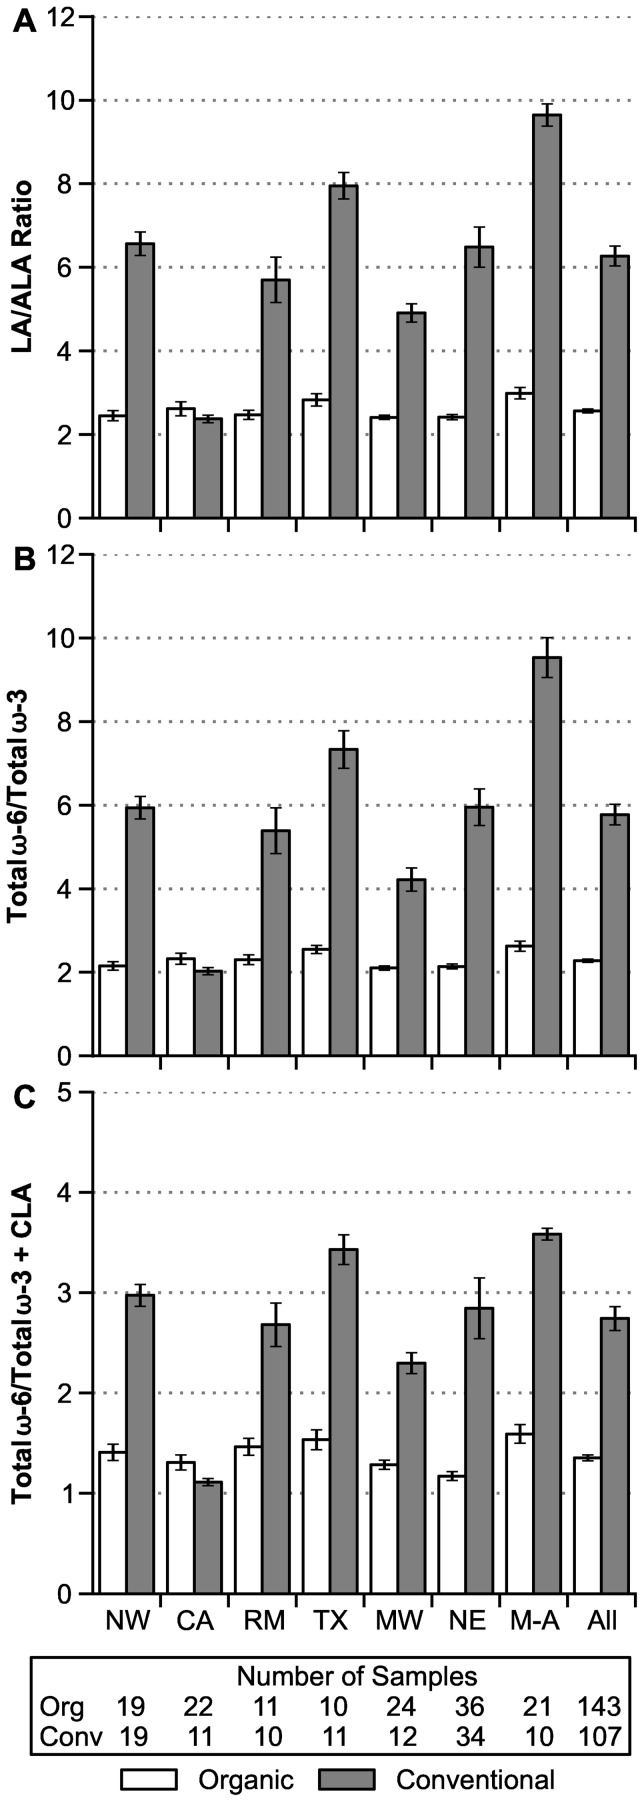
Regional variation in ratios involving ω-6 and ω-3 fatty acids (12-month average ± SE).
A: Linoleic acid/α-linolenic acid (LA/ALA). B: Total ω-6/total ω-3. C: Total ω-6/(total ω-3 + CLA). Abbreviations: Same as Fig. 1. Numbers of samples apply to all panels.